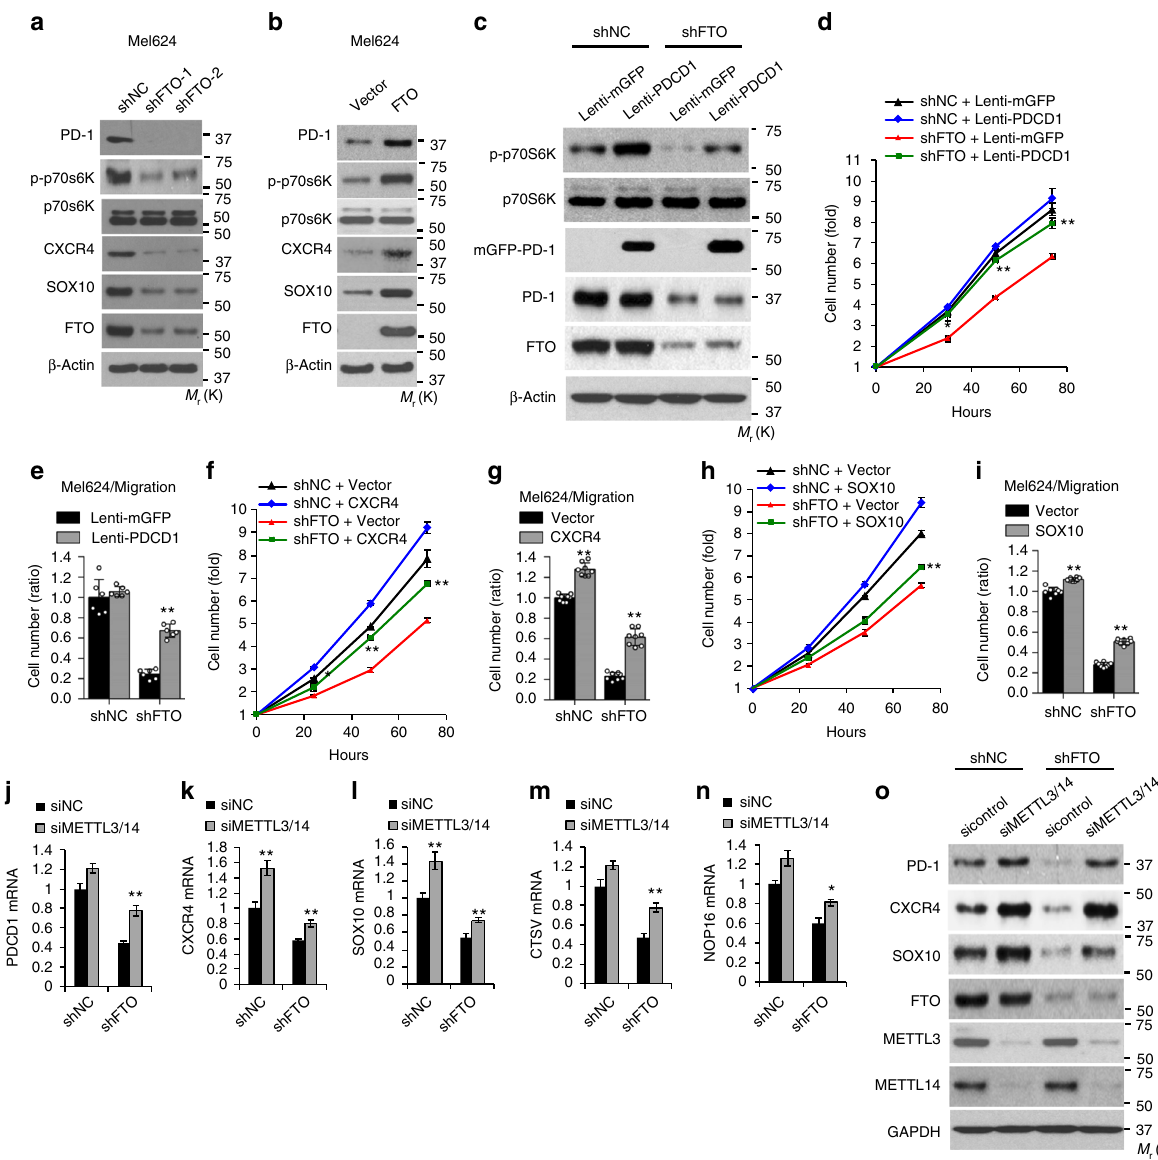
Fig. 5 PD-1 (PDCD1), CXCR4, and SOX10 are critical target genes of FTO in melanoma cells. a , b Immunoblot analysis of PD-1, p-p70S6K, p70S6K, CXCR4, SOX10, FTO, and β -actin in Mel624 stable cells with or without knockdown ( a ) and forced overexpression ( b ) of FTO. c Immunoblot analysis of PD-1, p- p70S6K, p70S6K, FTO, and β -actin in Mel624 with or without FTO knockdown, and/or PD-1 (PDCD1) overexpression. d Cell proliferation assay in cells as in c . e Cell migration assay in cells as in c . f , g Cell proliferation ( f ) and migration analysis ( g ) in Mel624 with or without FTO knockdown, and/or CXCR4 overexpression. h , i Cell proliferation ( h ) and migration analysis ( i ) in Mel624 with or without FTO knockdown, and/or SOX10 overexpression. j – n qPCR analysis of the expression of PD-1 (PDCD1) ( j ), CXCR4 ( k ), SOX10 ( l ), CTSV ( m ), and NOP16 ( n ) in Mel624 cells with or without FTO knockdown, in combination with siRNA knockdown of both METTL3 and METTL14. o Immunoblot analysis of PD-1, CXCR4, SOX10, FTO, METTL3, METTL14, and GAPDH in cells as in j – n . Data are shown as mean ± S.D. ( d – i ), or mean ± S.E. ( j – n ) ( n ≥ 3). * P < 0.05; ** P < 0.01; *** P < 0.001; Student ’ s t